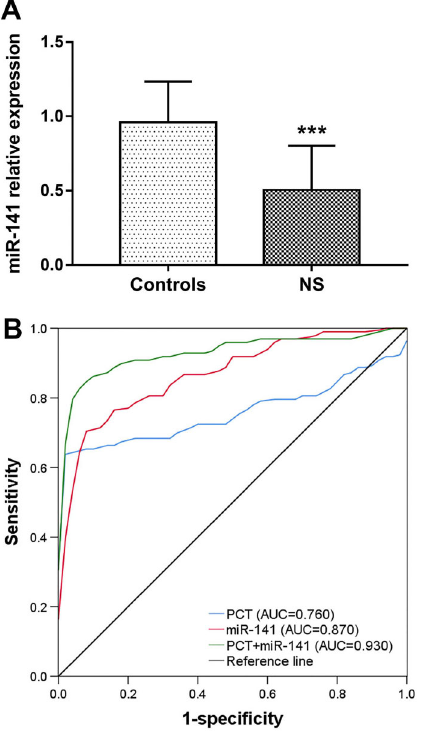
Figure 1. Serum expression of miR-141 in septic neonates (NS) and controls and its diagnostic performance results. A , Serum miR- 141 expression was decreased in NS compared with controls. Data are reported as means ± SD (***P o 0.001, t -test). B , ROC curves based on serum procalcitonin (PCT) and miR-141 for septic newborns (blue line for PCT; red line for miR-141; green line for the combination of PCT and miR-141). AUC: area under the curve.